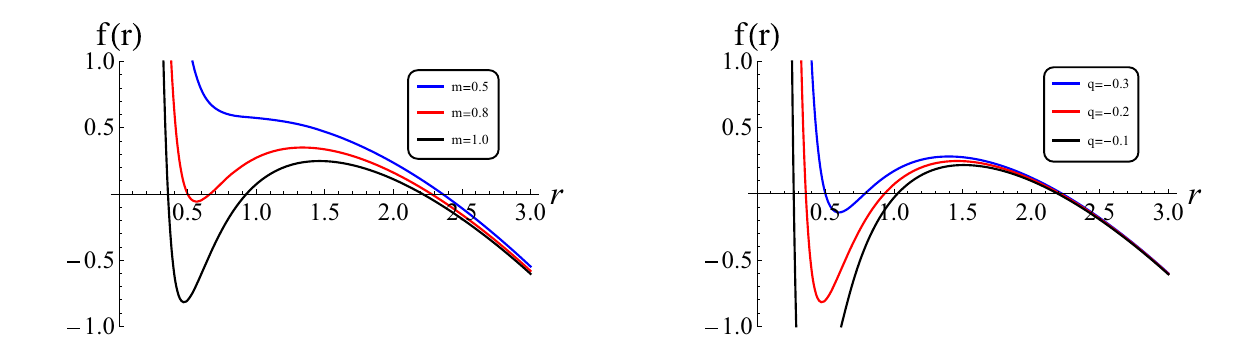
Fig. 1 The characteristic behavior of f ( r ) as a function of x for m = 0 . 5 , 0 . 8 , 1 . 0. The other parameters are fixed at Λ = 1, k = 1 , e = 0 . 2, and q = − 0 . 2